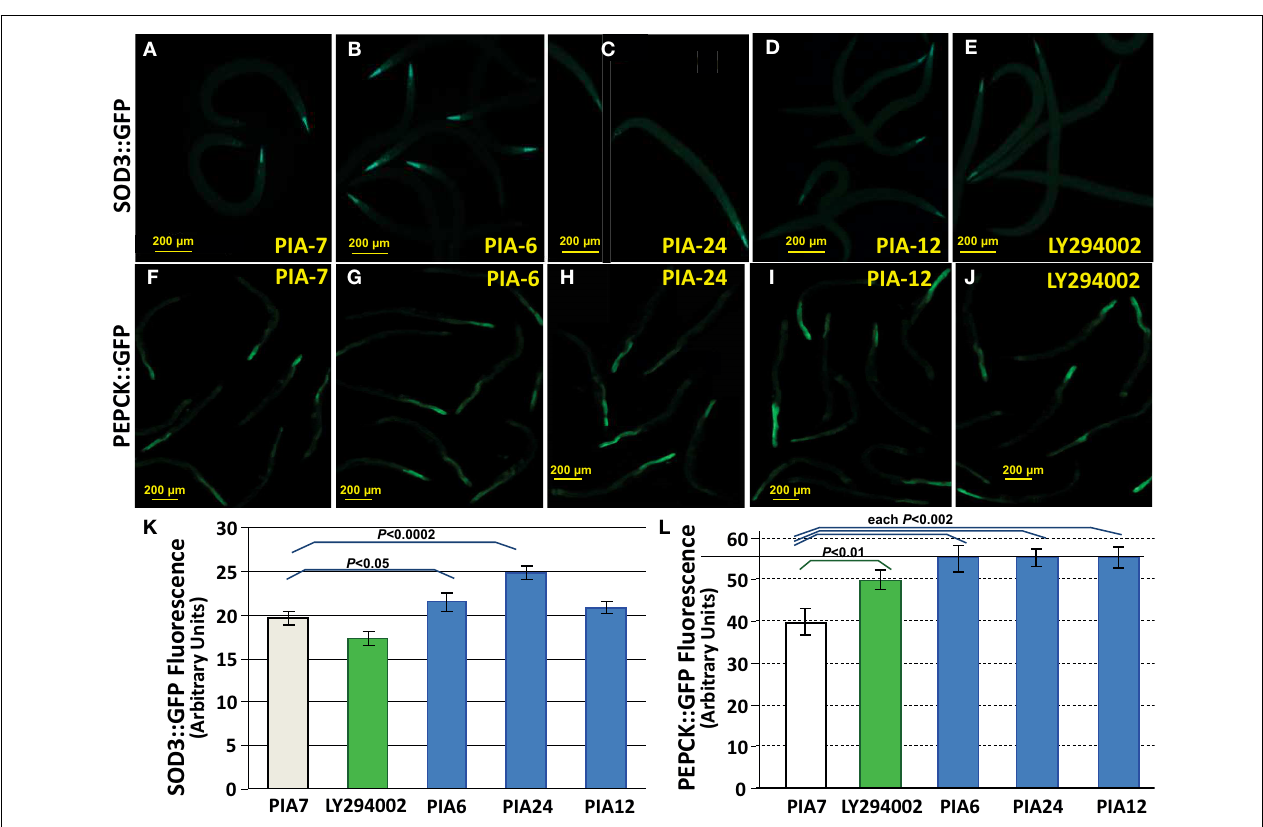
images of worms at 3 days of adult age, expressing PEPCK::GFP, after exposures as indicated. Bars in images indicate 200 µ m. Note that the SOD-3::GFP images are shown at slightly greater magnification than the PEPCK::GFP images. (K) , Histogram of mean ± SEM fluorescence for 10–20 worms per group, expressing SOD-3::GFP. (L) , Histogram of mean ± SEM fluorescence for 10–20 worms per group, expressing PEPCK::GFP.